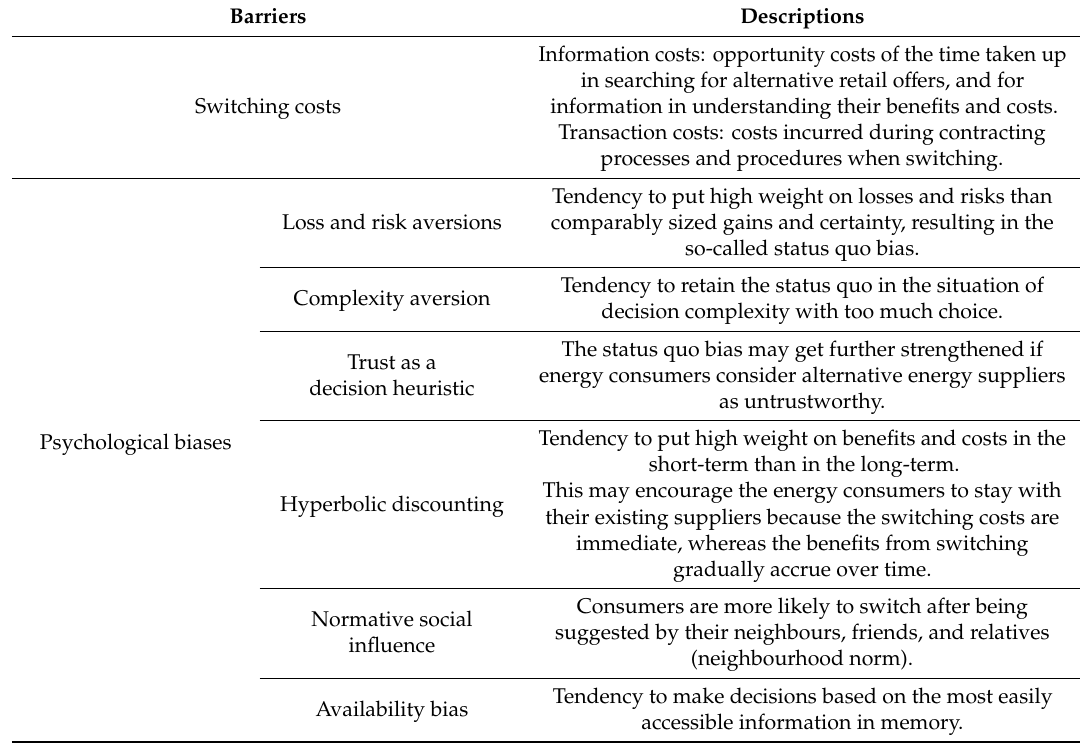
Table 1. Barriers for consumer